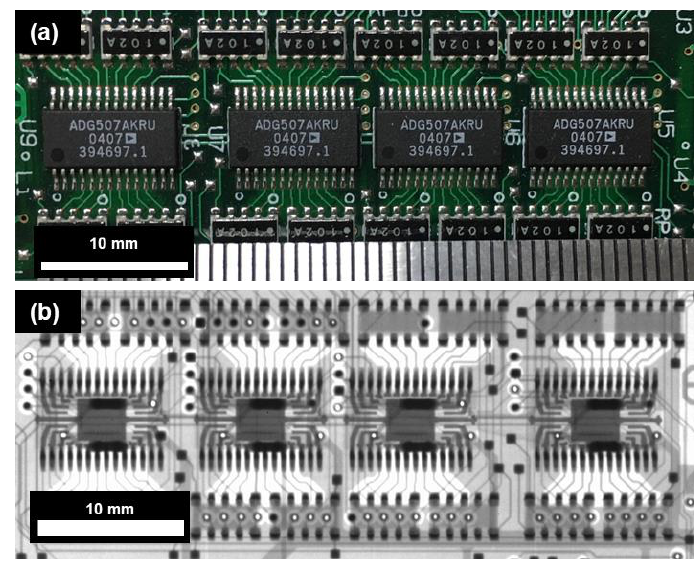
Figure 5. ( a ) The optical image and ( b ) X-ray image of integrated circuit taken at 55 kV/0.5 mA.